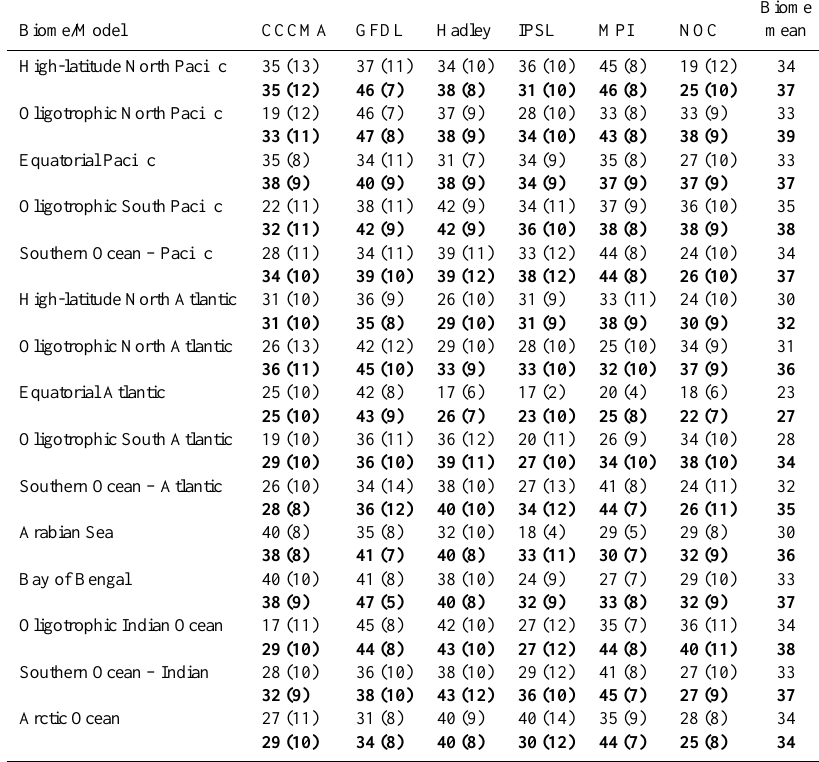
Table 3. Number of years of continuous data needed to detect a climate-change-driven trend above natural variability in primary production and the seasonal amplitude of primary production (bold) reported for each model as the average within the biome. One standard deviation of the spatial average is shown in